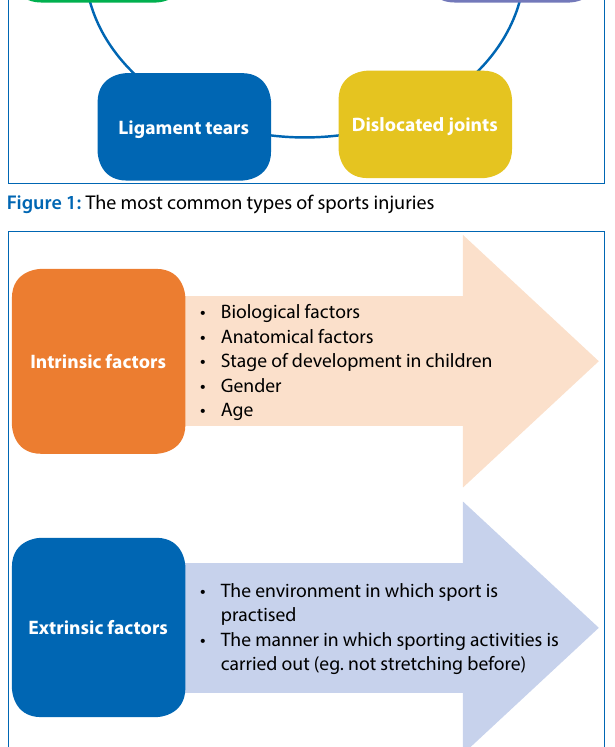
Figure 2: Risk factors of sports injuries